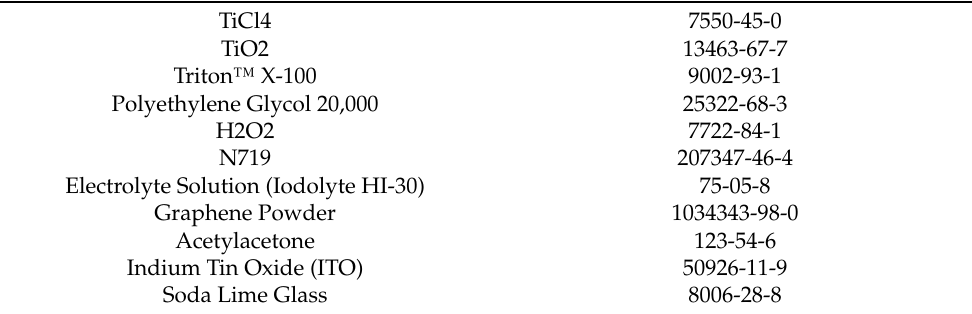
Table 1. Chemical abstracts service (CAS) numbers of all the chemical elements and